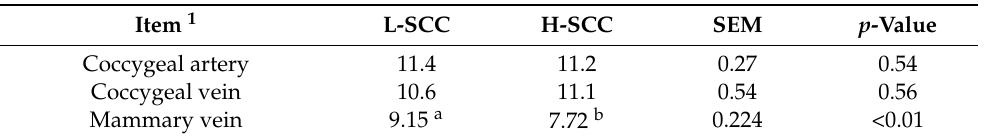
Table 3. Oxygen concentrations in different vessels of high-yielding dairy cows with different somatic cell counts